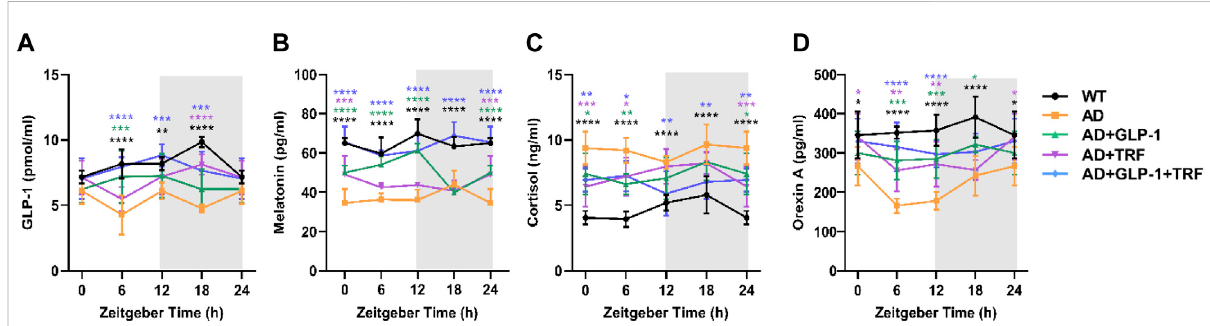
FIGURE 3 In fl uence of GLP-1and TRF on hormone secretion in mice. (A – D) Secretion levels of GLP-1, melatonin, cortisol, and orexin A in the fi ve groups of mice detected by ELISA, respectively. n = 6 each group, * p < 0.05, ** p < 0.01, *** p < 0.001, **** p < 0.0001 vs. AD group, using two-way ANOVA followed by Dunnett ’ s test. n = 6 per test and per